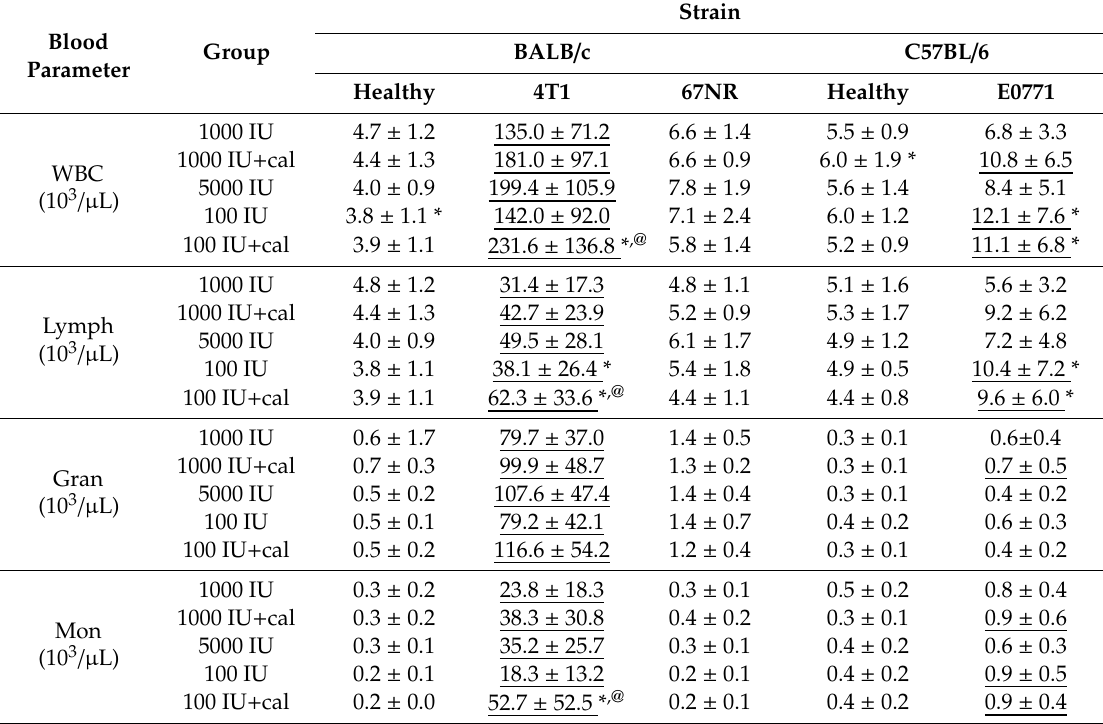
Table 5. Characteristics of white blood cells (WBCs) in BALB / c and C57BL / 6 healthy and mammary gland tumor-bearing